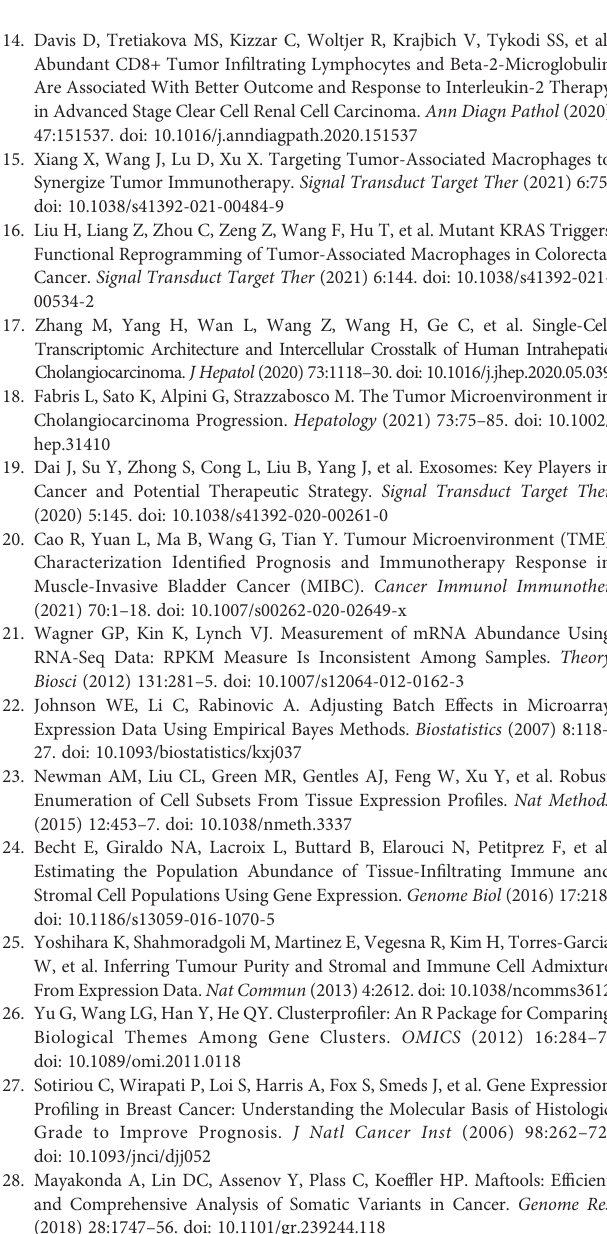
Supplementary Table S13 | Mutation status of HCC samples from TCGA-LIHC (0, absence of mutations; 1, presence of mutations). Supplementary Table S14 | Mutation status of HCC samples from TCGA-LIHC (0, absence of mutations; 1, presence of mutations). Supplementary Figure S1 | The work fl ow of the study design. Supplementary Figure S2 | Comparison of stages of HCC among distinct immune in fi ltration clusters. (A) HCC stage; (B) The proportion of HCC stage divided into early (I) and late HCC (II-IV). Supplementary Figure S3 | Correlations between ImmuneScore/StromalScore/ ESTIMATEScore and ICI score. Supplementary Figure S4 | Correlations between TMB value and expressions of the TOP 20 oncogenic drivers with the highest alteration frequency.